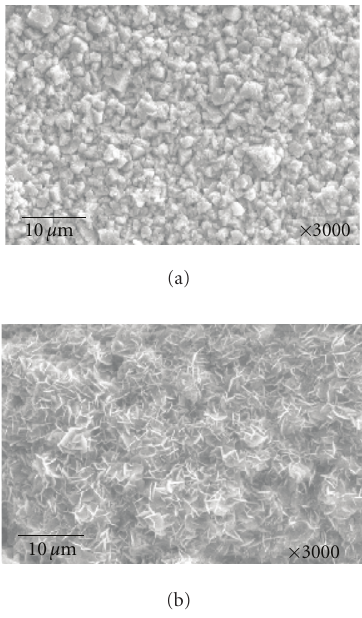
Figure 4: SEM images of alloy-coated (a) and composite-coated samples